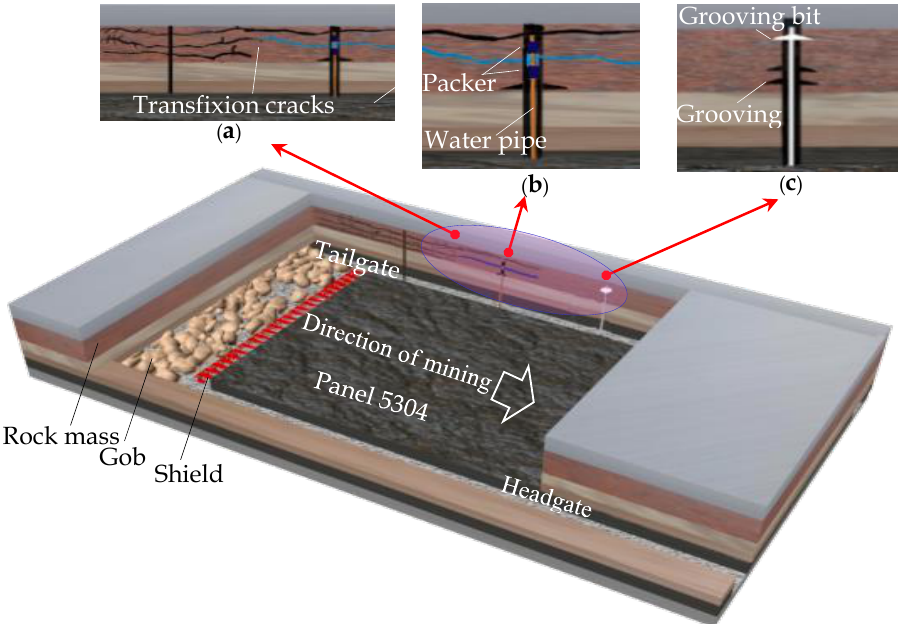
Figure 15. Hydraulic fracturing technology. ( a ) Cracks transfixion, ( b ) sealing and fracturing and ( c ) grooving.